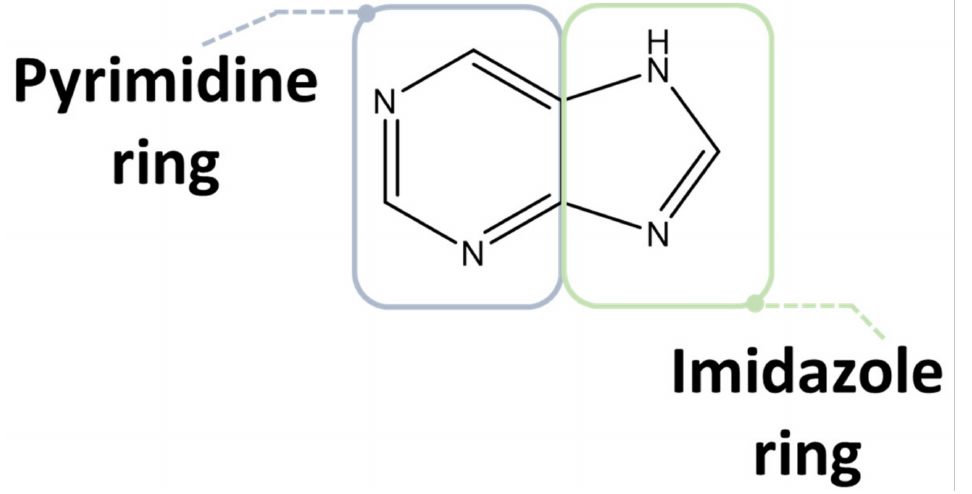
Figure 3. Double-ring structured purine compound.